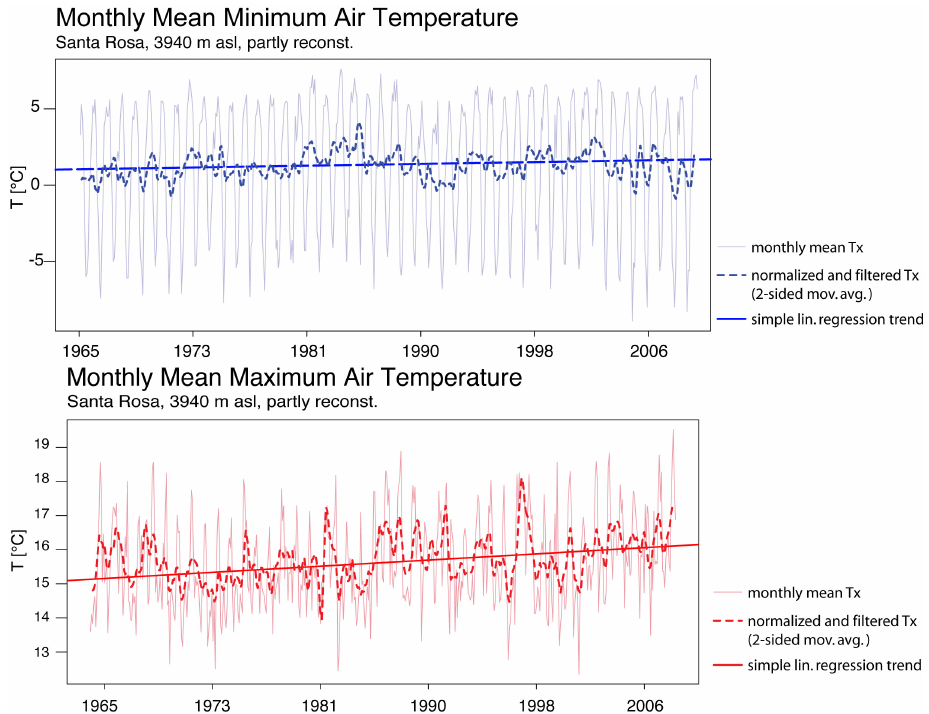
Fig. 4. Monthly minimum (a) and maximum (b) air temperature for Santa Rosa station. Dashed trend lines indicate where the p-value is above the significance level 0.05 (cf. also Table 4).